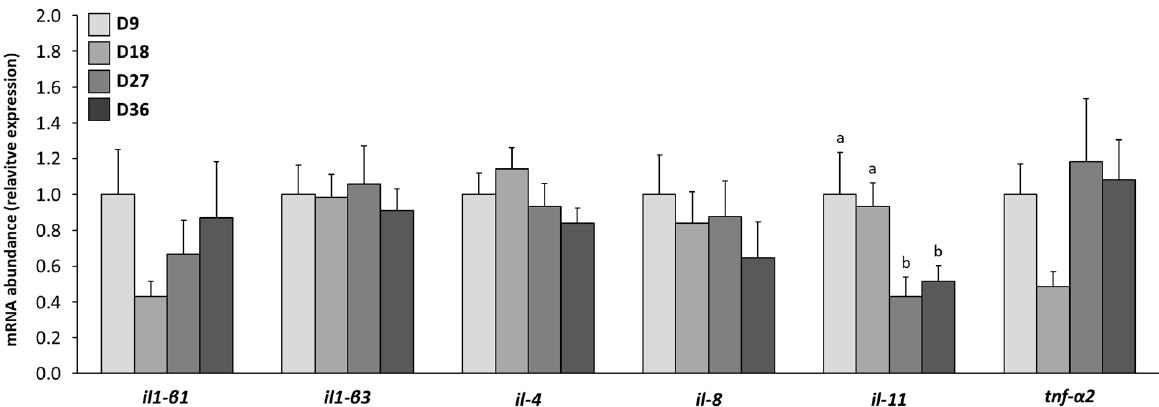
Figure 6. mRNA expression of transcripts related to inflammatory markers in red blood cells of rainbow trout hand-fed during 12 weeks with different stocking densities. Relative gene expression measured by RT-PCR of il1-B1, il1-B3, il-4, il-8, il-11 and tnf- α 2 in red blood cells of rainbow trout. Values are expressed as group mean ± SEM; fold change vs D9 density for all genes; one-way ANOVA followed by a post hoc Tukey’s test in case of significant differences ( p < 0.05, indicated with different letters. Mean values that do no share a common letter are significantly different).